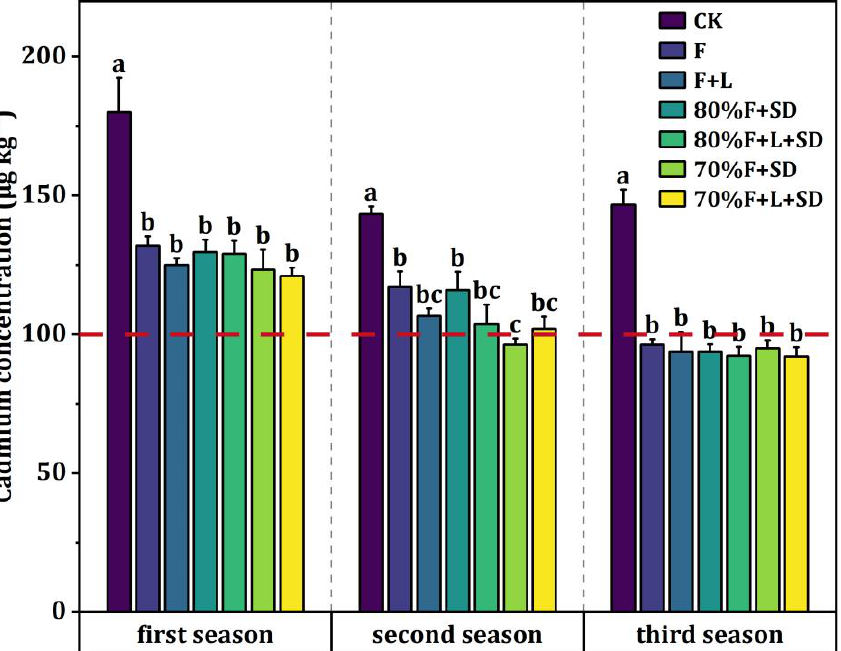
Figure 6. Effect of inorganic compound fertilizers on Cadmium concentration in edible parts of A. selengensis over three seasons. All values are means of three replicates with error bars indicating the standard error. Different lowercase letters show significant variability among treatments ( p < 0.05). The red dashed line indicates the standard limit of 0.1 mg kg −1 according to the Chinese Quality Standard for Food Safety — Limits of Contaminants in Food.